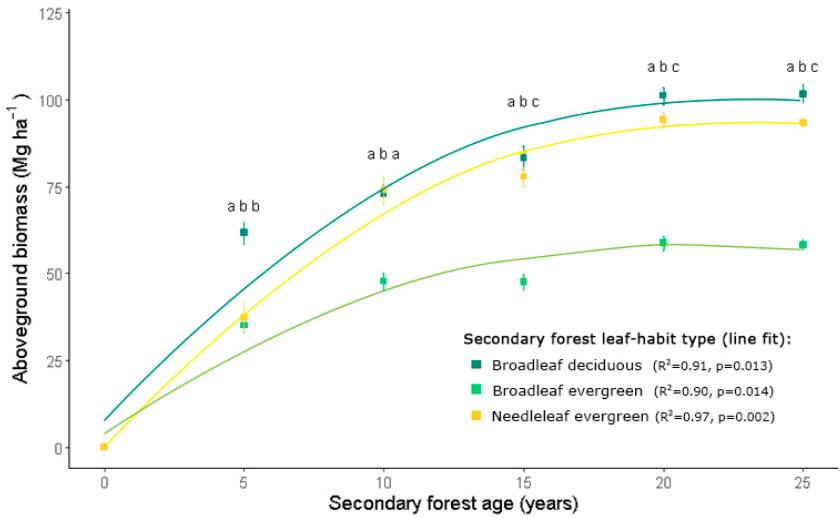
Figure 4. Average aboveground biomass (AGB) of secondary forests by age for the different forest leaf-habit types. Different letters indicate significant differences in AGB between forest leaf-habit types for the same age according to Tukey’s test ( p < 0.05).